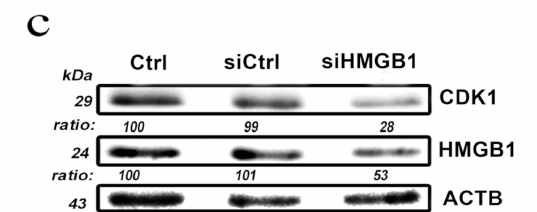
Figure 8. Functional validation of HMGB1 and expression of related genes in SW620 cell line. ( a ) Migration of SW620 cells assessed by wound healing assays. ( b ) HMGB1 knockdown efficiency. ( c ) HMGB1 knockdown reduces expression of its related gene CDK1 in SW620 cell line at protein level. * Statistically significant p -value calculated (Pearson correlation analysis) p < 0.05, ** p <